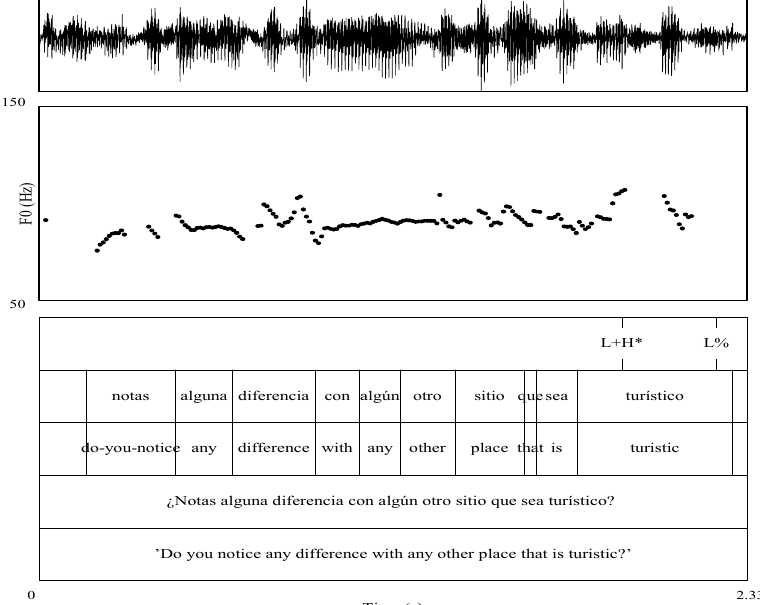
Figure 3. F0 contour of an absolute interrogative statement in Basque Spanish, by a male monolingual Spanish speaker from Lekeitio.